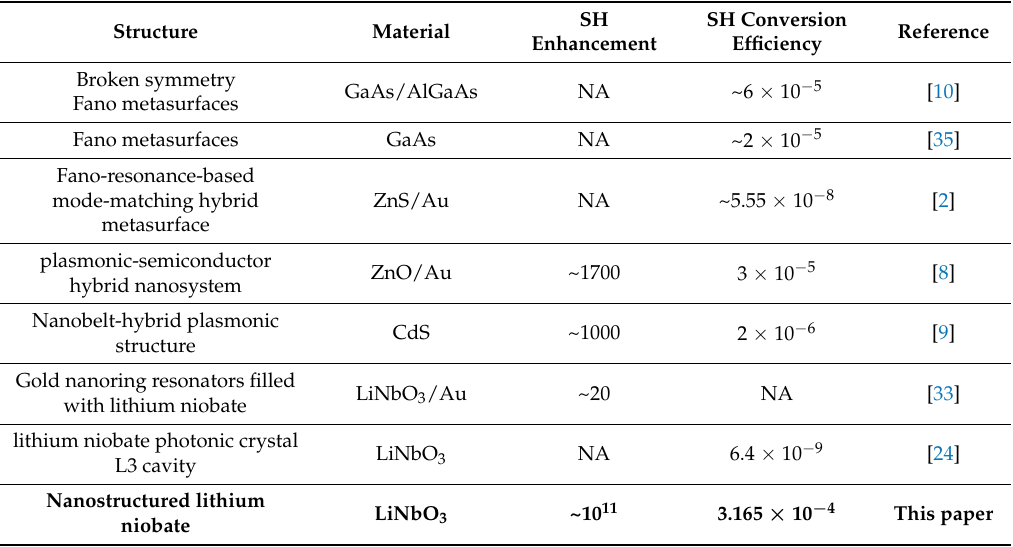
Table 1. Comparisons of the SH enhancement or conversion efficiency generated by different